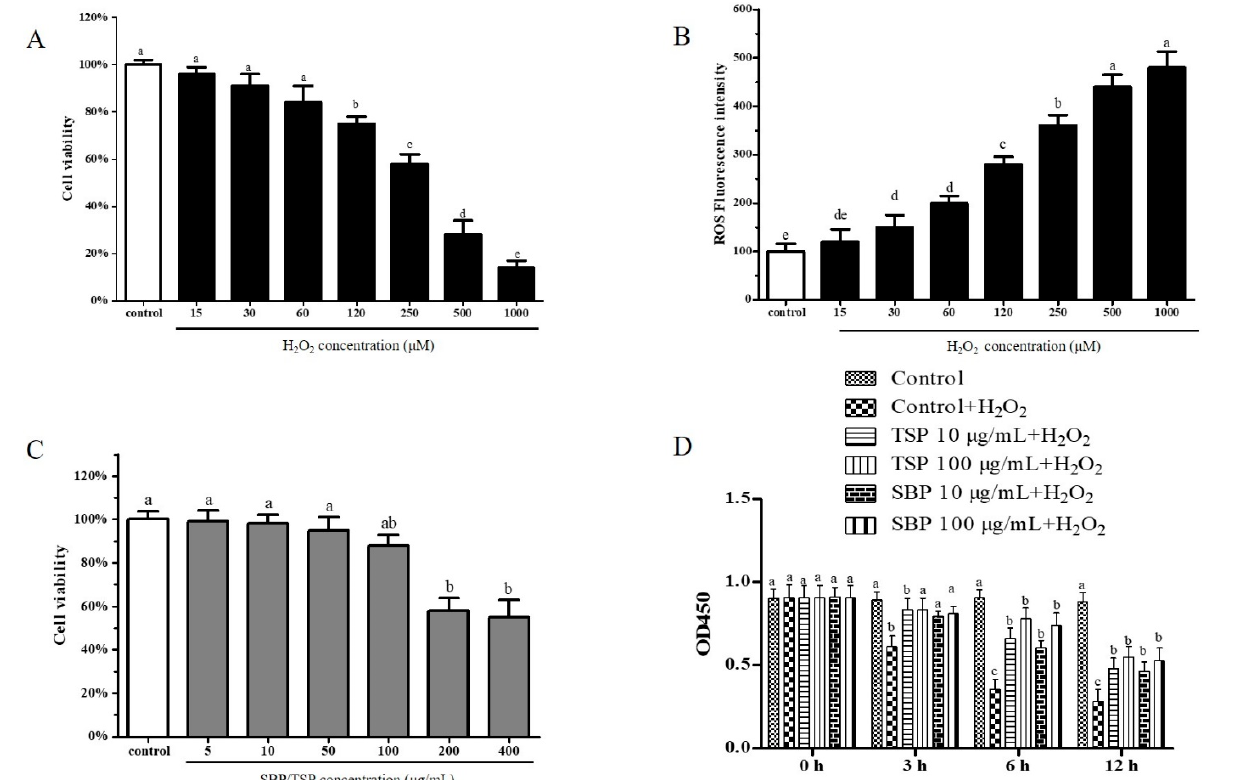
Figure 1. Viability of PC-12 cells under the influence of H 2 O 2 ( A ), an PC-12 cells generation under the influence of H 2 O 2 ( B ), Viability of PC-12 cells under the influence of peptides ( C ), PC-12 cells’ intracellular ROS scavenging capacities of different concentrations of peptides and different incubation time under oxidative stress induced by H 2 O 2 ( D ). Data are expressed as the mean ± SD. The results marked with the different letters (a, b, c, d and e)are significantly different ( p < 0.05).